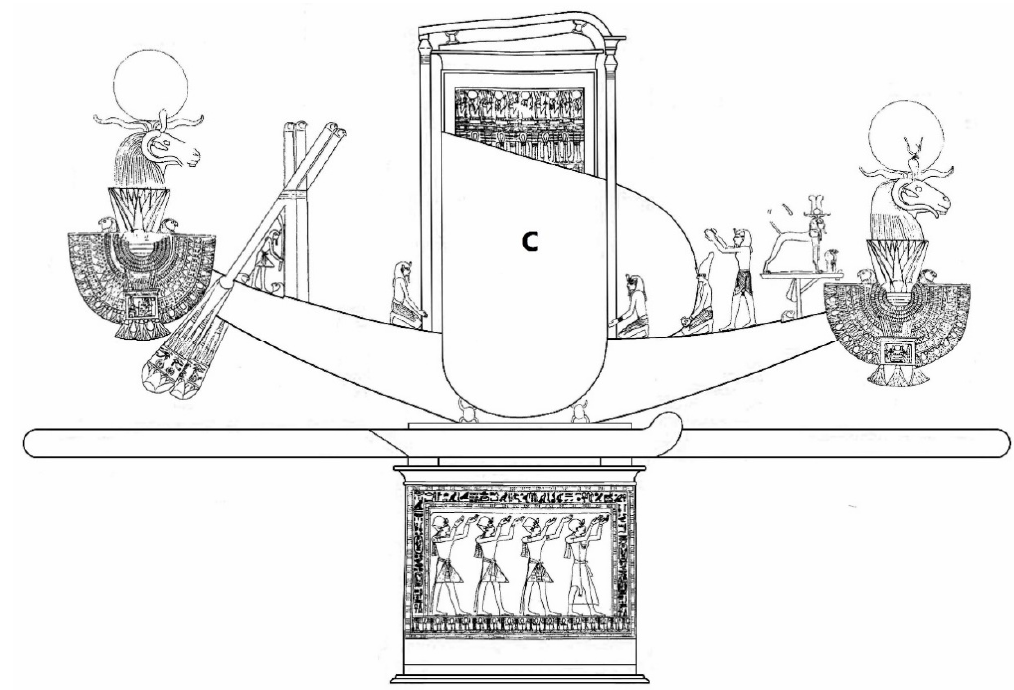
Figure 4. Depiction of a sacred bark laid on the sarcophagus of Pharaoh Seti I, from the chapel of Amen-Re in the Seti temple in Abydos, dated to the 13th century BCE (Gardiner 1935, Pl. 5). A large portable shrine is located on top of a boat, with its door partly covered by a white curtain (marked C). Part of the curtain flutters to the right.